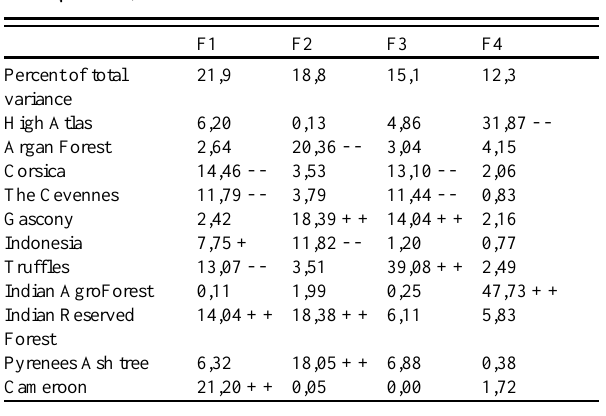
Table 2 . Contributions of the case studies to the first four axes (F1 to F4) provided by the Multiple Correspondence Analysis (MCA). -- or ++ means a highly significant contribution to the axis (p<0.01)